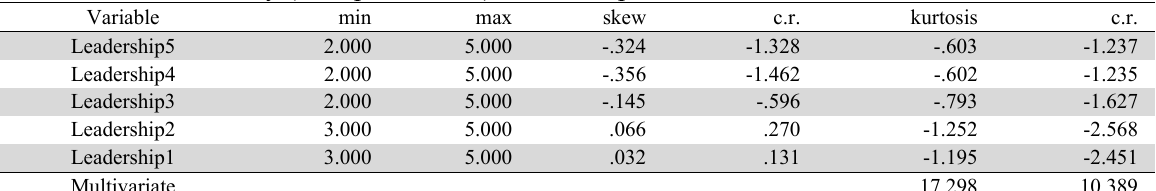
Assessment of normality (Group number 1), Leadership Variables